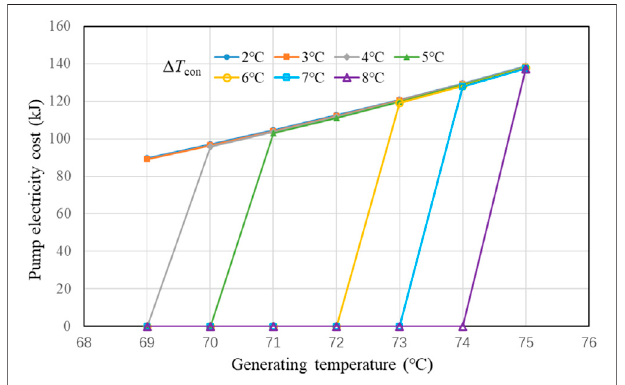
FIGURE 8 | Analysis on cooling energy of ERC with variation in evaporating temperature and condenser temperature difference.